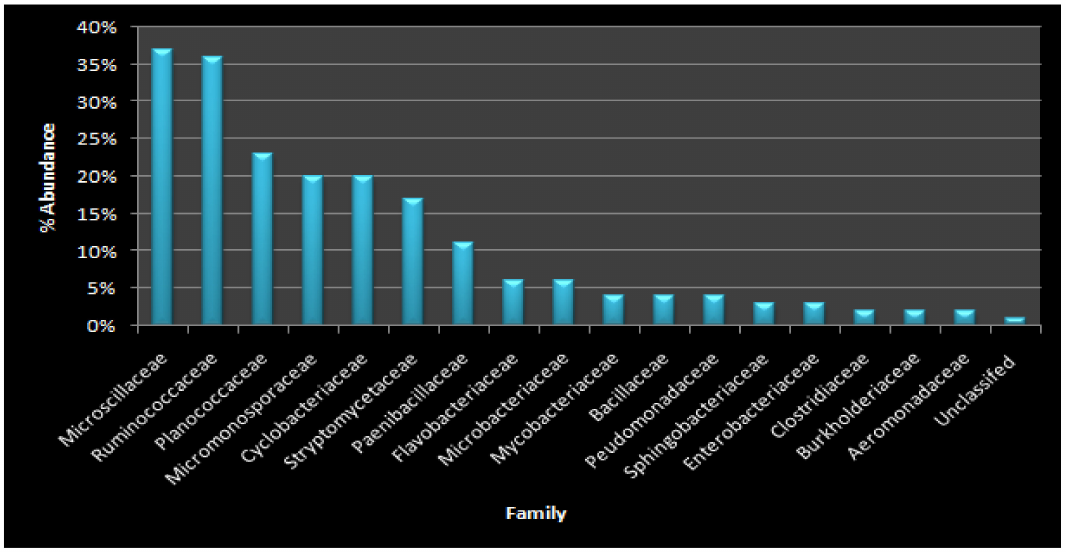
Figure 10. Family-level distribution of the bacteria groups present in compost sample